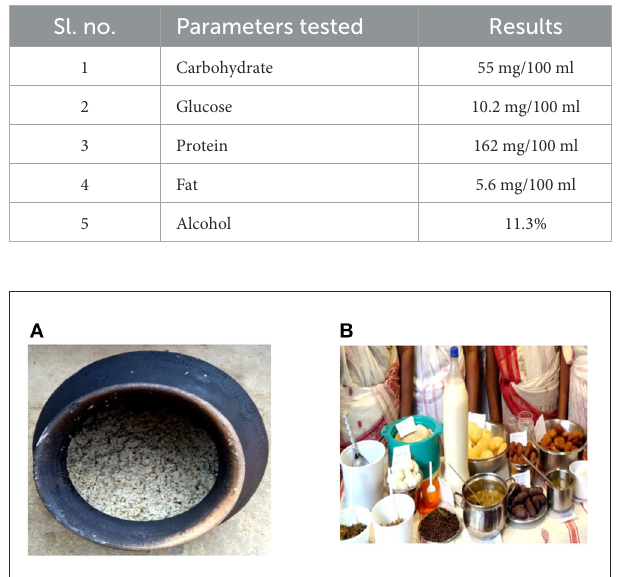
FIGURE4 Fermented food: (A) Raw handia . (B) Consumable handia in a bottle with other festive foods.